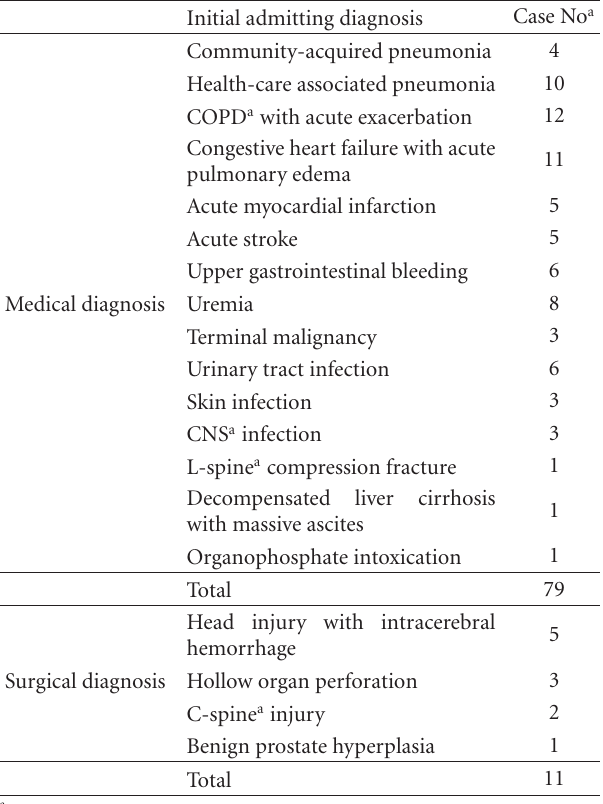
Table 1: Initial admitting diagnosis in VAP a